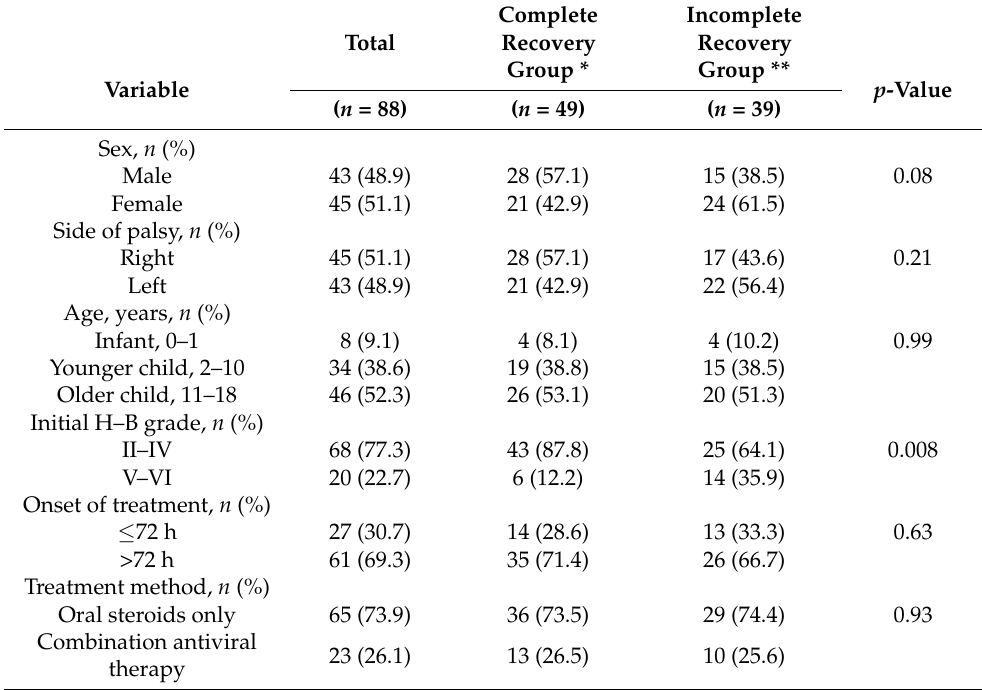
Table 2. Baseline demographic and clinical characteristics at admission and outcomes at 6 months according to the severity of Bell’s